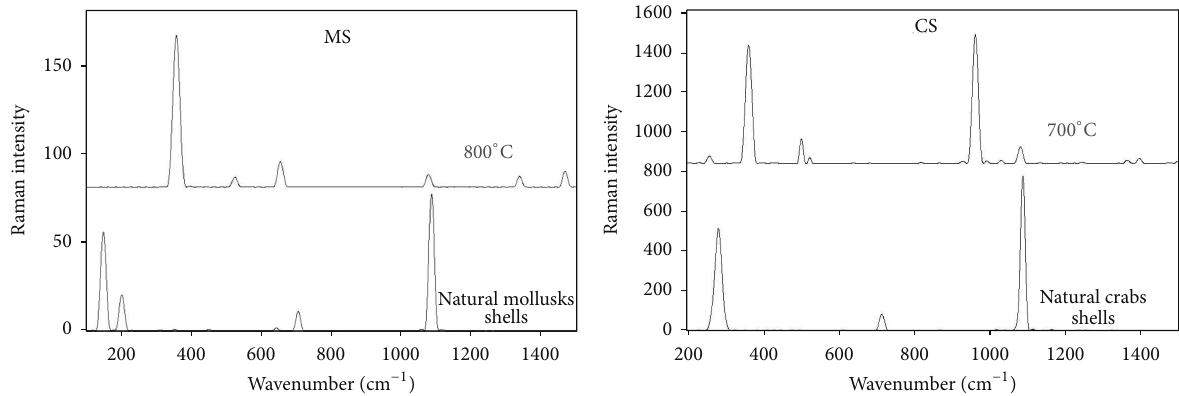
Figure 3: Raman spectra at different calcination temperatures.